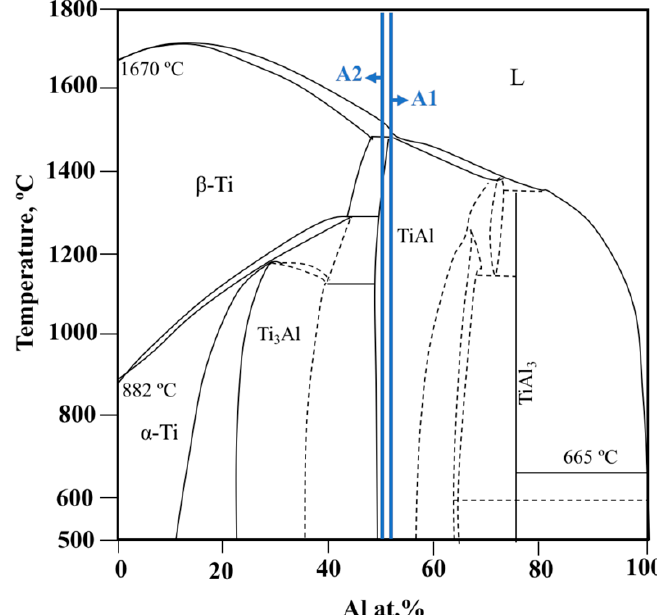
Figure 6. Ti-Al phase diagram, where the Ti:Al atomic ratios of A1 and A2 zones are plotted, adapted from [19], with permission of Elsevier, 2018. from [19], with permission of Elsevier, 2018.